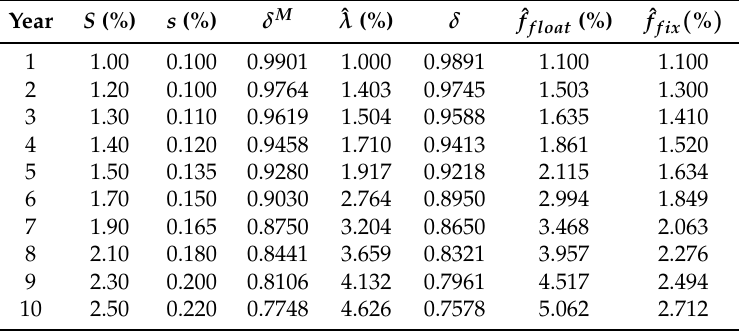
Table 2. Funding curve and calculated values for ˆ f float and ˆ f fix .